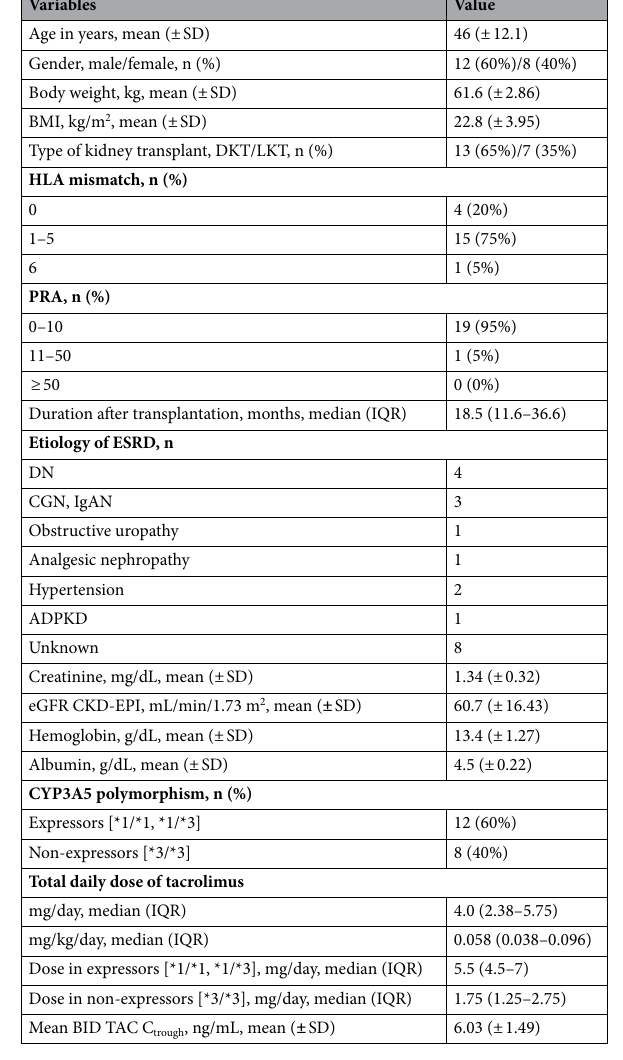
Table 1. Characteristics of study participants at first intensive PK assessment. SD: standard deviation; HLA: human leukocyte antigens; DKT: deceased donor kidney transplantation; LKT: living donor kidney transplantation; PRA: panel reactivity antibody; DN: diabetic nephropathy; CGN: chronic glomerulonephritis; IgAN: immunoglobulin A nephropathy; ADPKD: autosomal dominant polycystic kidney disease;